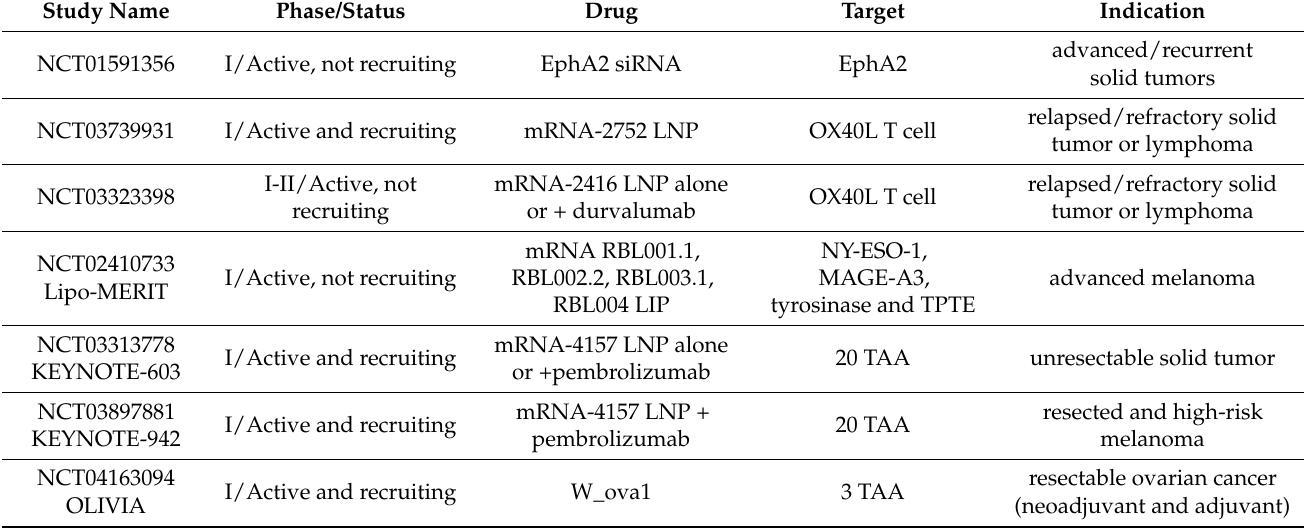
Table 3. Ongoing studies with RNA-loaded